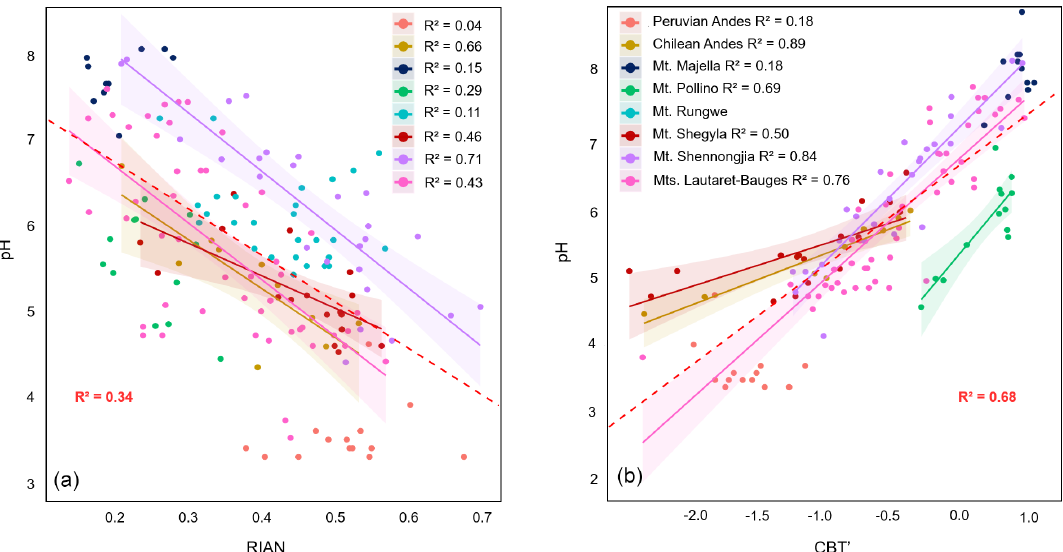
Figure 4. Linear regressions between (a) pH and RIAN and (b) pH and CBT’ along the eight altitudinal transects investigated. Dotted lines represent the 95% confidence interval for each regression, and coloured areas represent the 95% confidence interval for each regression. Data for Mt. Majella and Mt. Rungwe were taken from Huguet et al. (2019). Data from Mt. Shennongjia were taken from Yang et al. (2015) and Wang et al. (2016). Data from Mt. Bauges and Mt. Lautaret-Galibier were taken from Véquaud et al. (2021). Only significant regressions ( p < 0 . 05) are